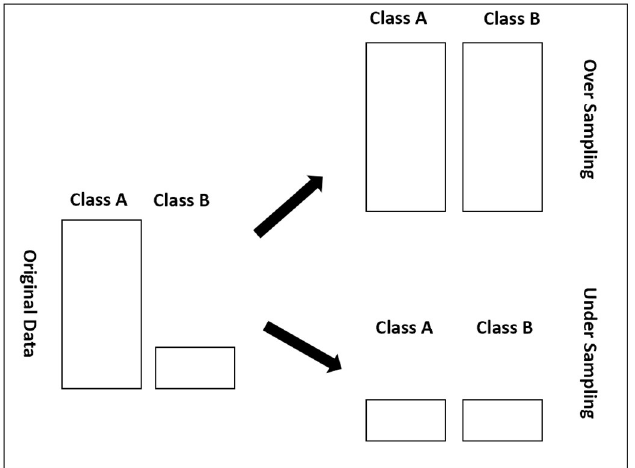
Fig 2. Representation of Over and Under